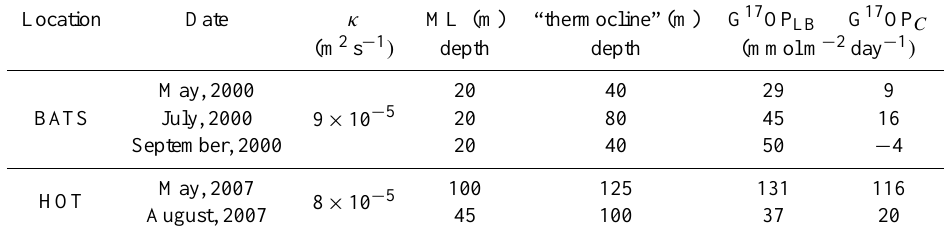
Table 3. Comparison of G 17 OP rates from BATS and HOT ML – mixed layer, G 17 OP LB – Luz and Barkan (2000), “thermocline” – depth of the data point representing the thermocline. G 17 OP C – G 17 OP corrected for turbulent flux of O 2 from the thermocline. All the parameters used for the calculations made in BATS were taken from Luz and Barkan (2009). κ values and the raw data used for the calculation of G 17 OP LB and G 17 OP C , and the parameters used for the calculations in HOT were taken from Nicholson et al. (2012). ML depth was determined as the depth in which a difference of 0.5% in O 2 concentration relative to the sea surface was observed. Gas-exchange rates in HOT were calculated according to Sweeney et al. (2007) from wind speed data obtained from